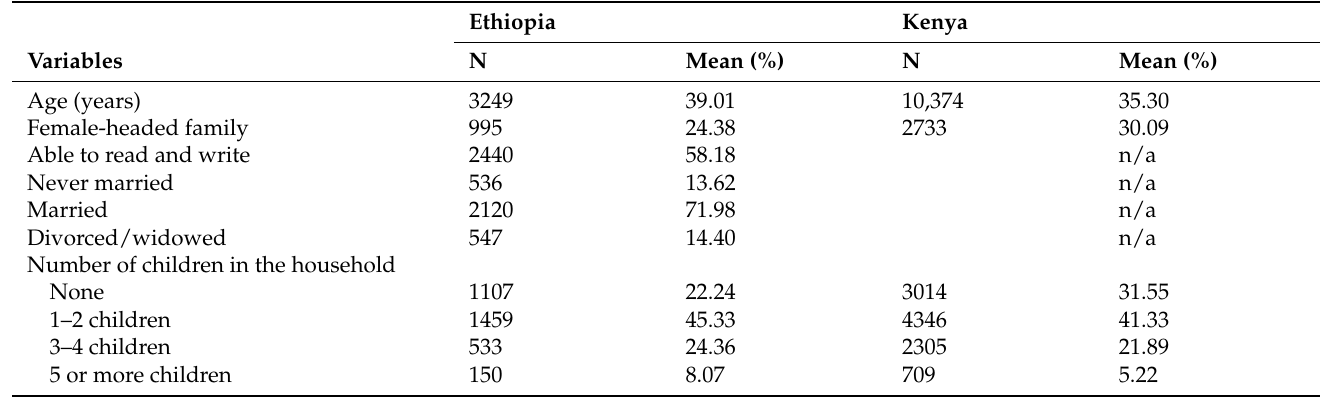
Table 1. Weighted summary statistics for selected variables (using wave 1 data for Kenya and